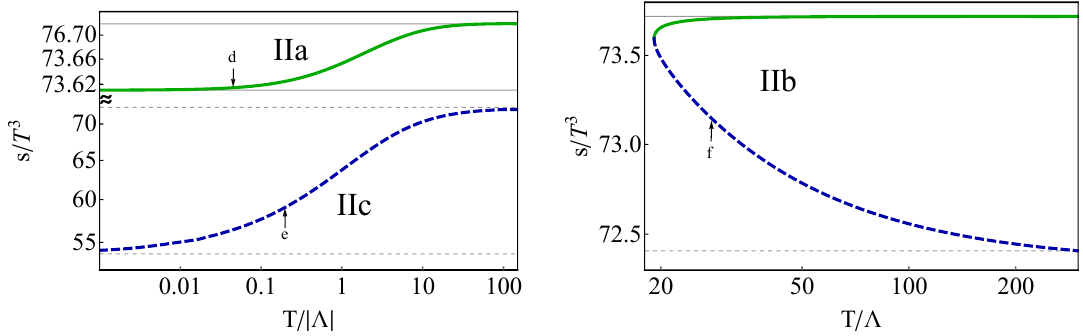
Figure 11 . Entropy density versus temperature of the CFT 3 with negative (left) and positive (right) source (cid:3). The horizontal lines are as in (cid:12)gure 10. In dashed blue locally stable but globally unstable and in solid green thermodynamically preferred. Regions of the potential IIa, IIb, IIc, map to the thermodynamic branches here. The labels d, e and f are the values for the thermal states dual to the gravity solutions presented in (cid:12)gure